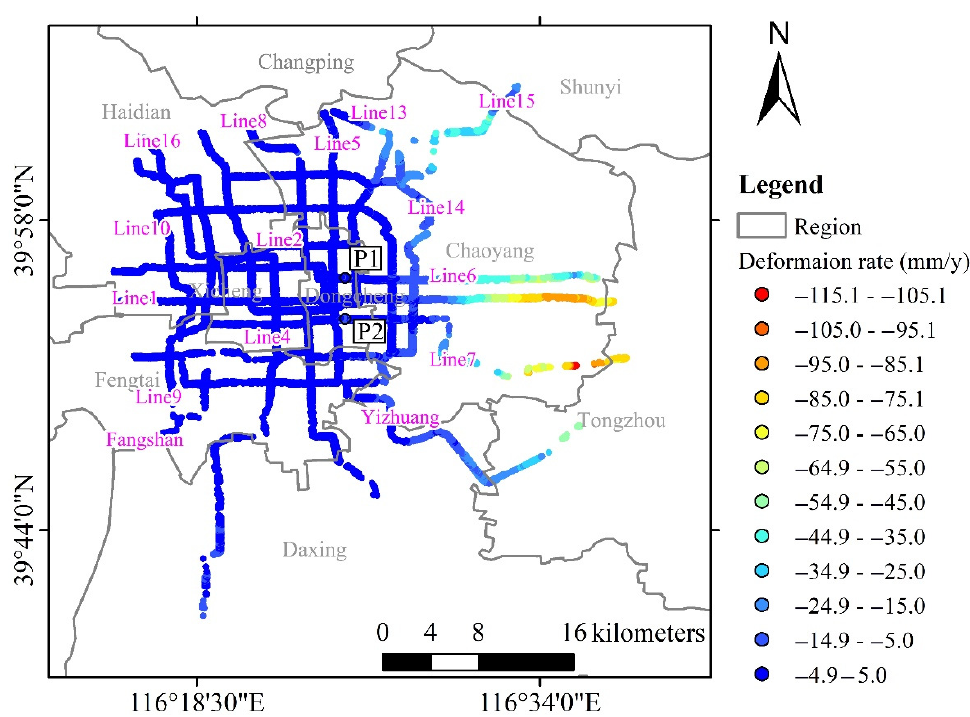
Figure 11. Deformation rates along Beijing subway lines. Table 4. Properties of the subway lines in the study